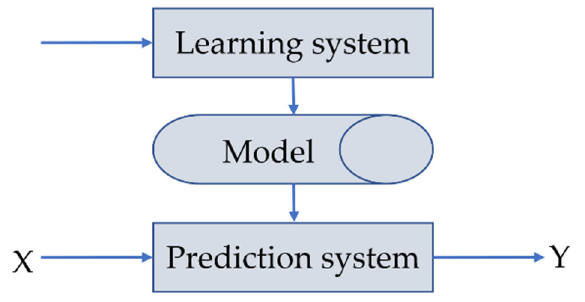
Figure 6. Graphic description of regression.